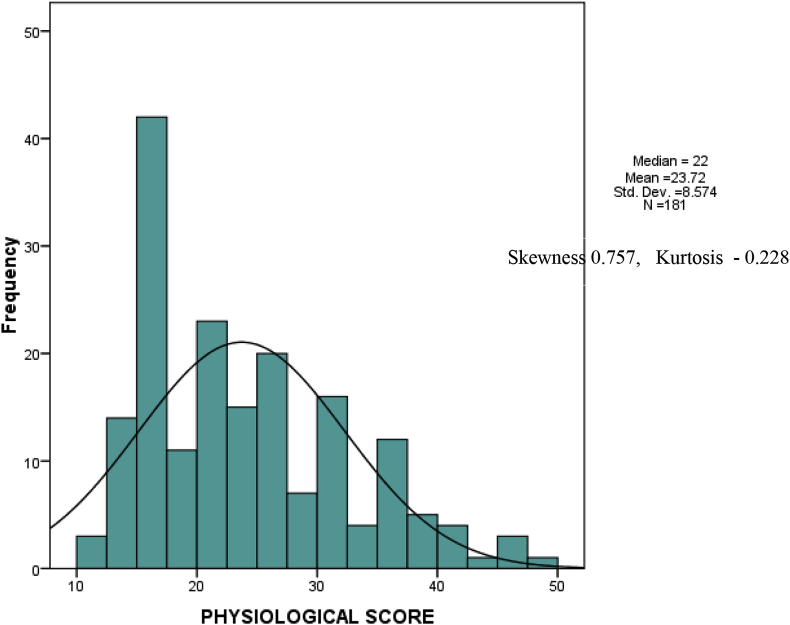
Distribution of preoperative physiological score.